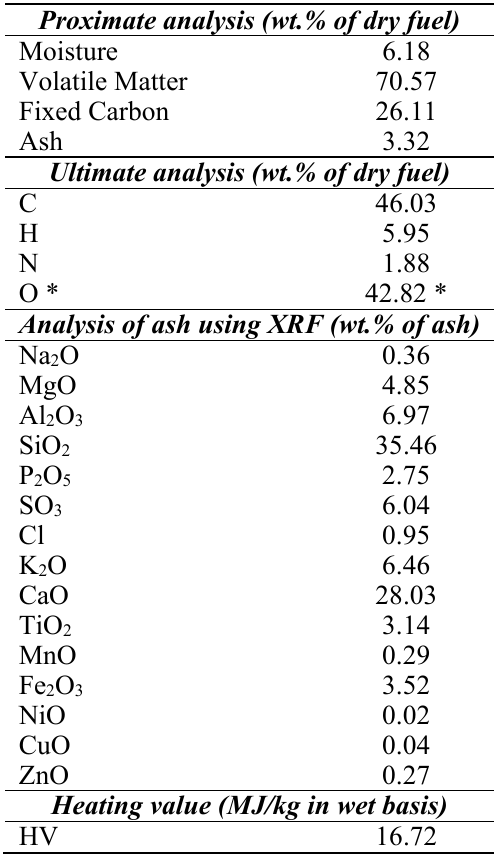
Figure 1. Picture of the experimental facility: a lab-scale low-power biomass combustion boiler. The deposition probe position is indicated. Table 1. Fuels characterization: proximate analysis, ultimate analysis and ash analysis of the wood